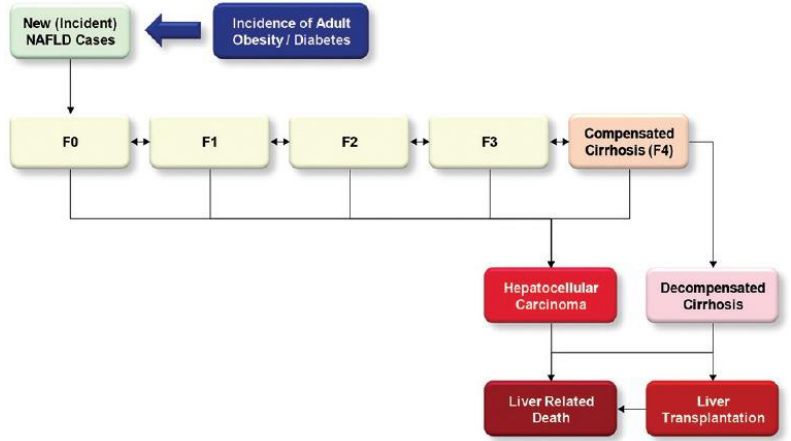
Figure 2. Example of NAFLD progression model [liver fibrosis can be divided into four stages (F1–4) as follows: F0—no fibrosis; F1—portal fibrosis without septa; F2—portal fibrosis and few septa; F3—numerous septa without cirrhosis; F4—cirrhosis, adapted from [4]. In most cases, abdominal ultrasonography is used to diagnose NAFLD [7]. Ultrasonography is a low-cost, safe, quick, and uncomplicated procedure in most healthcare settings [8]. To determine the severity of liver disease, non-invasive testing or liver biopsies are used. Hepatic steatosis, inflammation, and fibrosis are all assessed with a liver biopsy. However, a liver biopsy is an intrusive procedure that may result in a